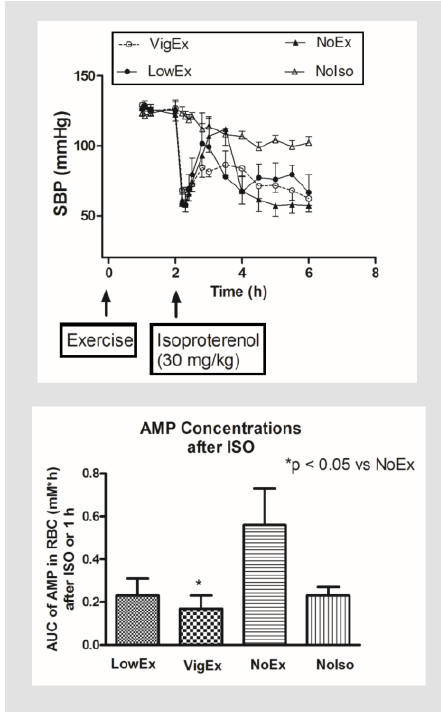
Figure 5. Effect of acute exercise preconditioning on systolic blood pressure (SBP) ( top ) and RBC concentrations of AMP ( bottom ). Each point represents mean ± SEM. (Abbreviations: VigEx = 14 m/min and 22% gradient; LowEx = 10 m/min and 10% grade; NoEx = No exercise; and NoIso = No isoproterenol.